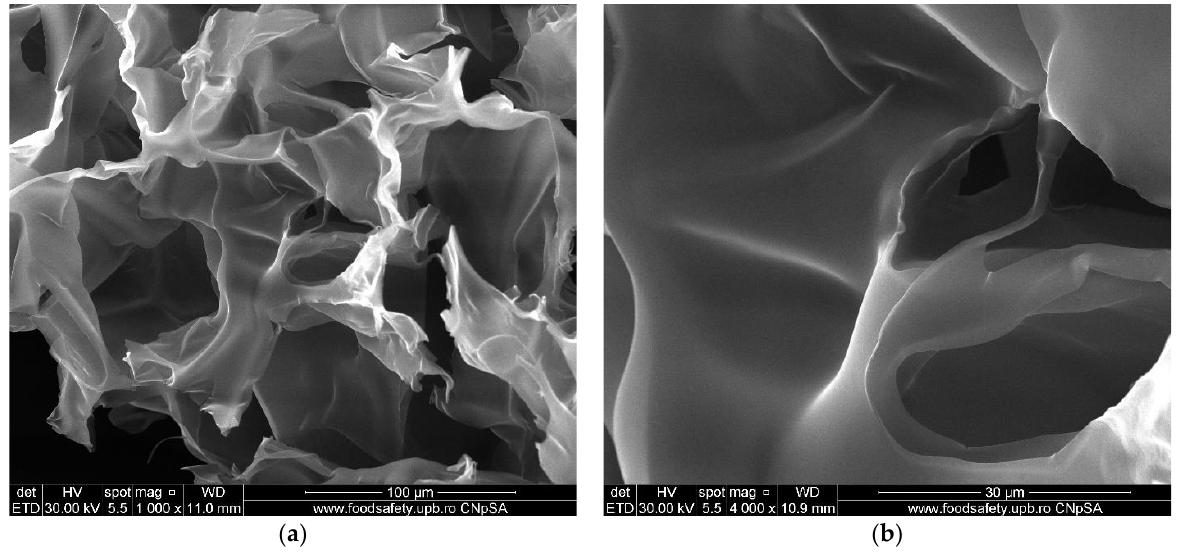
Figure 8. SEM images of simple chitosan CS membrane: ( a ) 1000× magnification, ( b ) 4000× magnification.